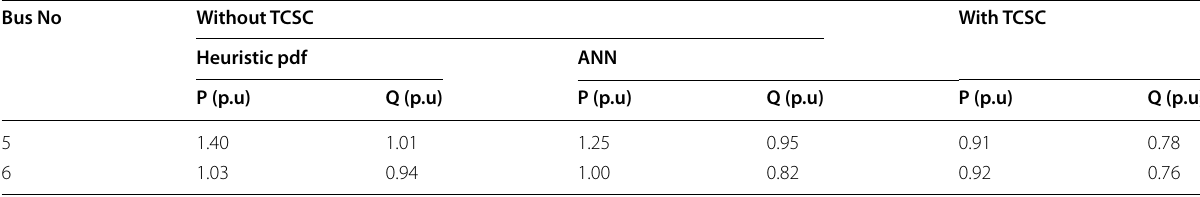
Table 16 Power flow comparison with and without presence of TCSC between the buses no. 5 and 6 for IEEE 9- bus system Bus No Without TCSC With TCSC